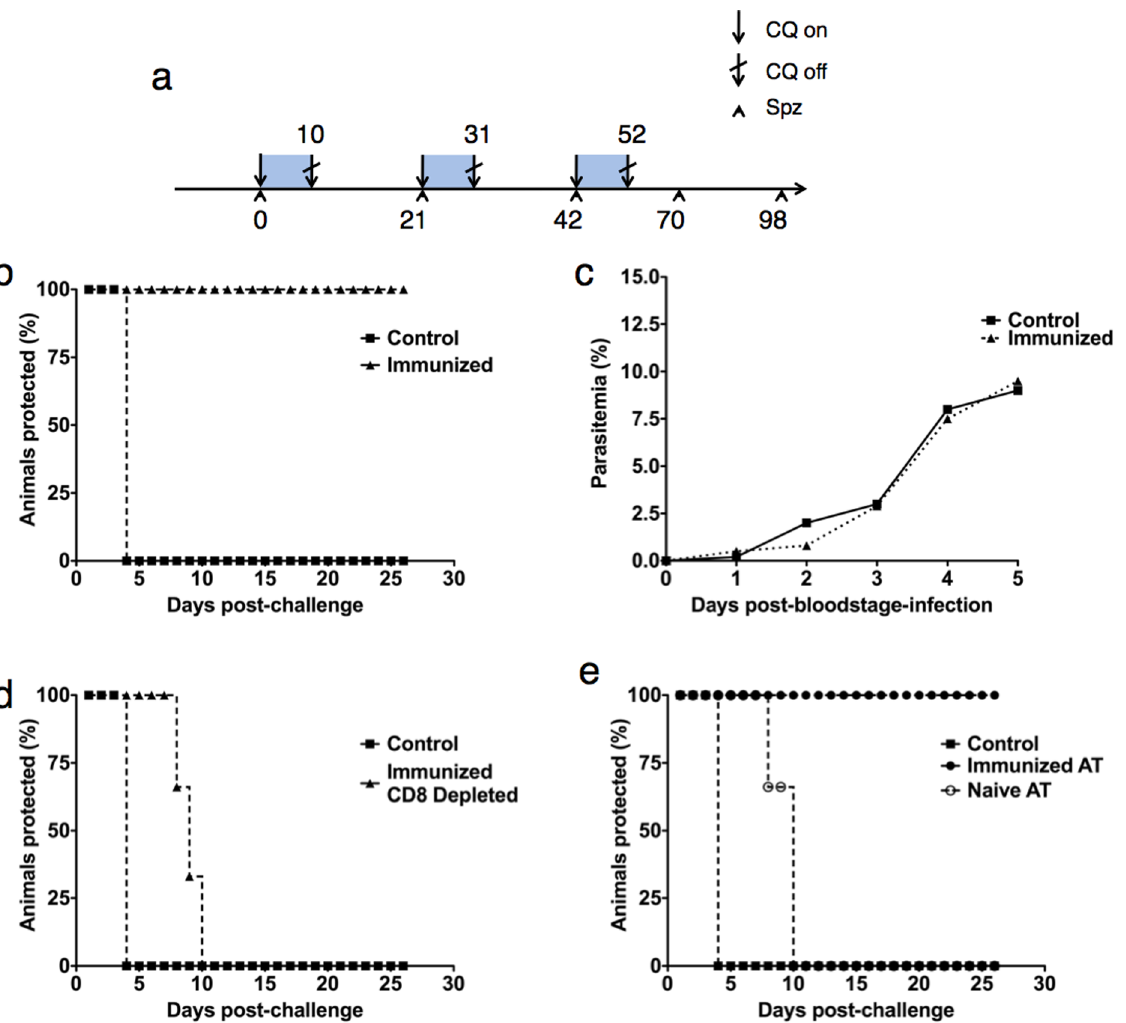
Figure 2. Figure 2a. Scheme to illustrate the CPS immunization regime. Animals were subjected to three immunization shots of 10,000 Pb NK65 sporozoites at days 0, 21 and 42. Immediately after each immunization animals were administered chloroquine ad libitum for 10 days. Blue blocks represent periods of time under chloroquine cover. Animals were subjected to challenge with 10,000 sporozoites at day 70 and, in some cases, rechallenged at day 98. Figure 2b. CPS vaccination generates sterilizing immunity against subsequent P.berghei challenge. Animals (n=10) were subjected to CPS as described and subsequently challenged with 10,000 Pb NK65 sporozoites at day 70 post-first-immunization. Naı¨ve age-matched animals in the Control group were challenged with 10,000 sporozoites only. Animals were monitored for presence of blood stage parasitemia via Giemsa staining of daily blood smears. Figure 2c. CPS vaccination does not protect against blood stage challenge. Animals (n=5) were subjected to CPS as described and subsequently challenged with 1 6 10 6 parasitized erythrocytes at day 70 post-first-immunization, 28 days post-third-immunization. Naı¨ve age-matched animals in the Control group were challenged with 1 6 10 6 parasitized erythrocytes only. Animals were monitored for presence of blood-stage parasitemia via Giemsa staining of daily blood smears. Figure 2d. CD8 + T cells are essential for sterilizing immunity elicited by CPS vaccination. Animals (n=6) were subjected to CPS as described, subsequently depleted of their CD8 + T cells via administration of neutralizing antibody and subsequently challenged with 10,000 sporozoites at day 70 post-first-immunization, 28 days post-third-immunization. Naı¨ve age-matched animals in the Control group were challenged with 10,000 sporozoites only. Animals were monitored for presence of blood-stage parasitemia via daily staining of Giemsa blood smears. Comparison of curves P=0.0009 by Log-rank (Mantel-Cox) Test. Figure 2e. Protective immunity can be transferred to naı¨ve animals by adoptive transfer of splenocytes. Animals (n=6) were subjected to CPS as described. CPS immunized animals were sacrificed and their splenic lymphocytes isolated and purified and 2 6 10 7 transferred into a group of naı¨ve recipient animals, ‘‘Immunized AT’’. Control recipient animals, ‘‘Naı¨ve AT’’, received splenocytes from naı¨ve donors. All experimental groups, including a naı¨ve group were challenged with 10,000 sporozoites 24 hours later. Animals were monitored for presence of blood-stage parasitemia via daily staining of Giemsa blood smears. Comparison of ‘‘Immunized AT’’ and ‘‘Naı¨ve AT’’ curves P=0.025 by Log-rank (Mantel-Cox) Test. Comparison of all three curves P=0.091 by Log-rank (Mantel-Cox)